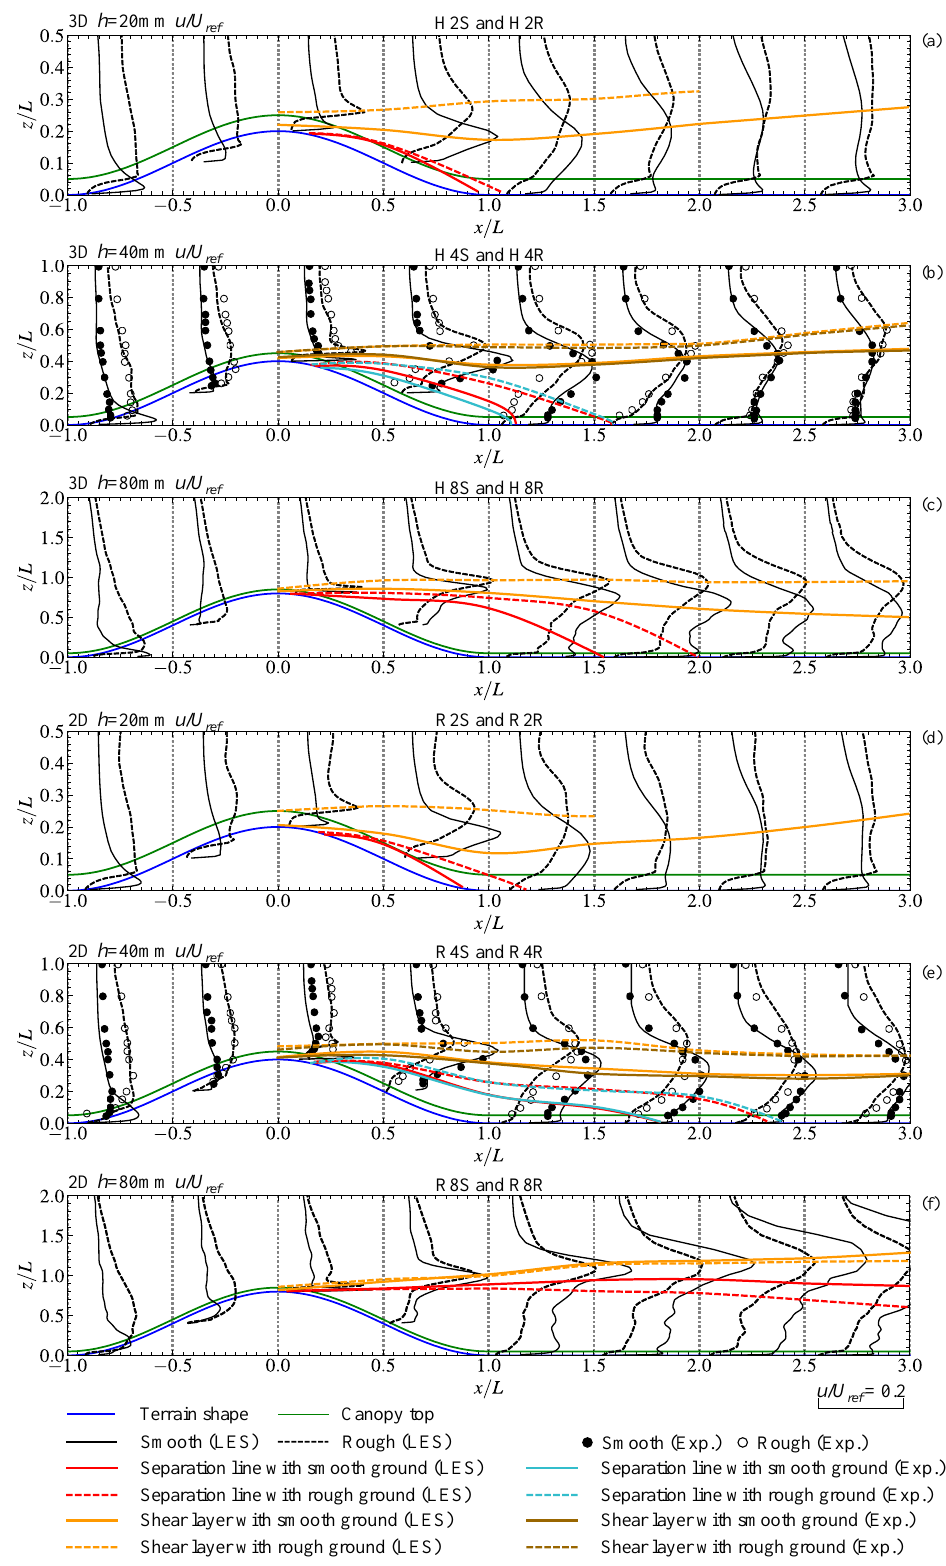
Figure 6. Vertical profiles of u , ( a ) 3D hills with h = 20 mm, ( b ) 3D hills with h = 40 mm, ( c ) 3D hills with h = 80 mm, ( d ) 2D hills with h = 20 mm, ( e ) 2D hills with h = 40 mm, and ( f ) 2D hills with h = 80 mm.